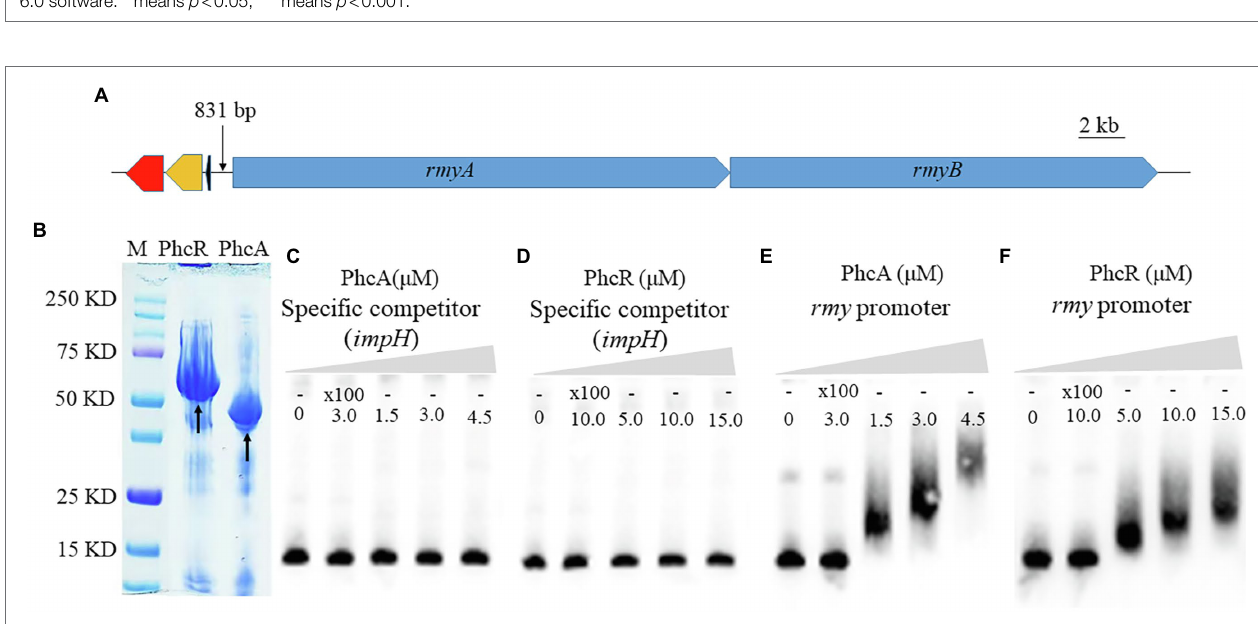
FIGURE 5 | Coculture experiment between R. solanacearum and FOC4 (A) and the chlamydospores counts (200 magnification times) in their interaction zones (B) . Δ phcA and Δ phcR refers to deletion of phcA and phcR from wide type strain EP1, respectively; Δ phcA ( phcA ) and Δ phcR ( phcR ) refers to the complementary strain of Δ phcA and Δ phcR , respectively. Each assay was repeated for three independent experiments with at least three replications per trial. Mean values of all experiments were averaged with SD (error bars) and statistical significance was assessed using a paired two-tailed Student’s t -test by using the GraphPad Prism